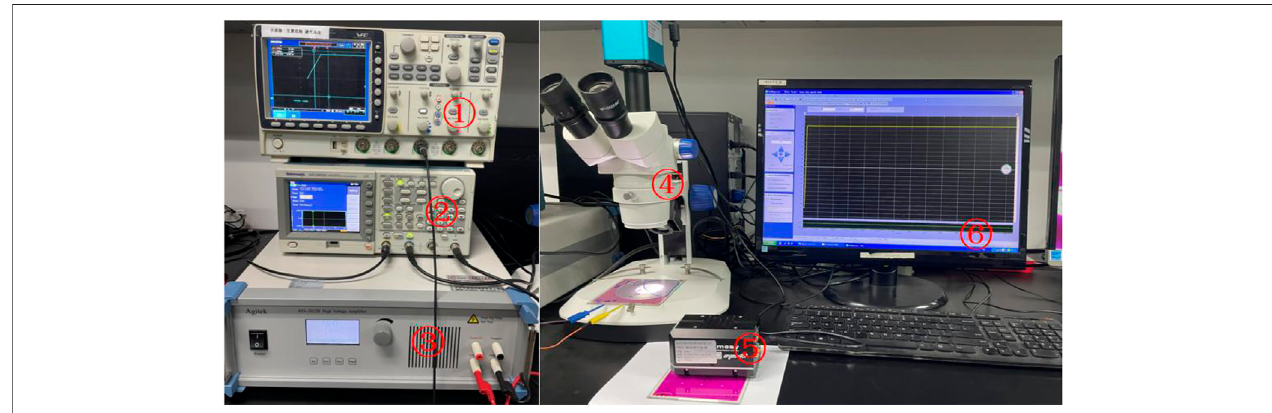
FIGURE 5 | Experimental platform for driving EWDs. ① Oscilloscope. ② Arbitrary waveform generator. ③ Power ampli fi er. ④ Microscope. ⑤ Colorimeter. ⑥